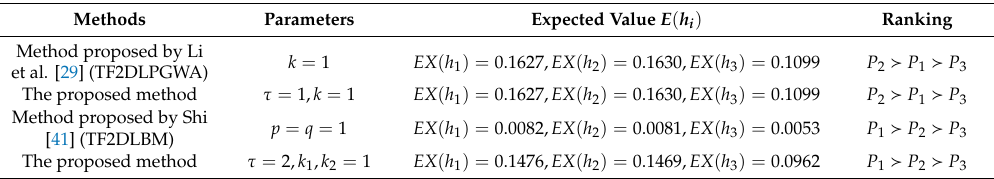
Table 7. Results obtained by di ff erent MADM methods.